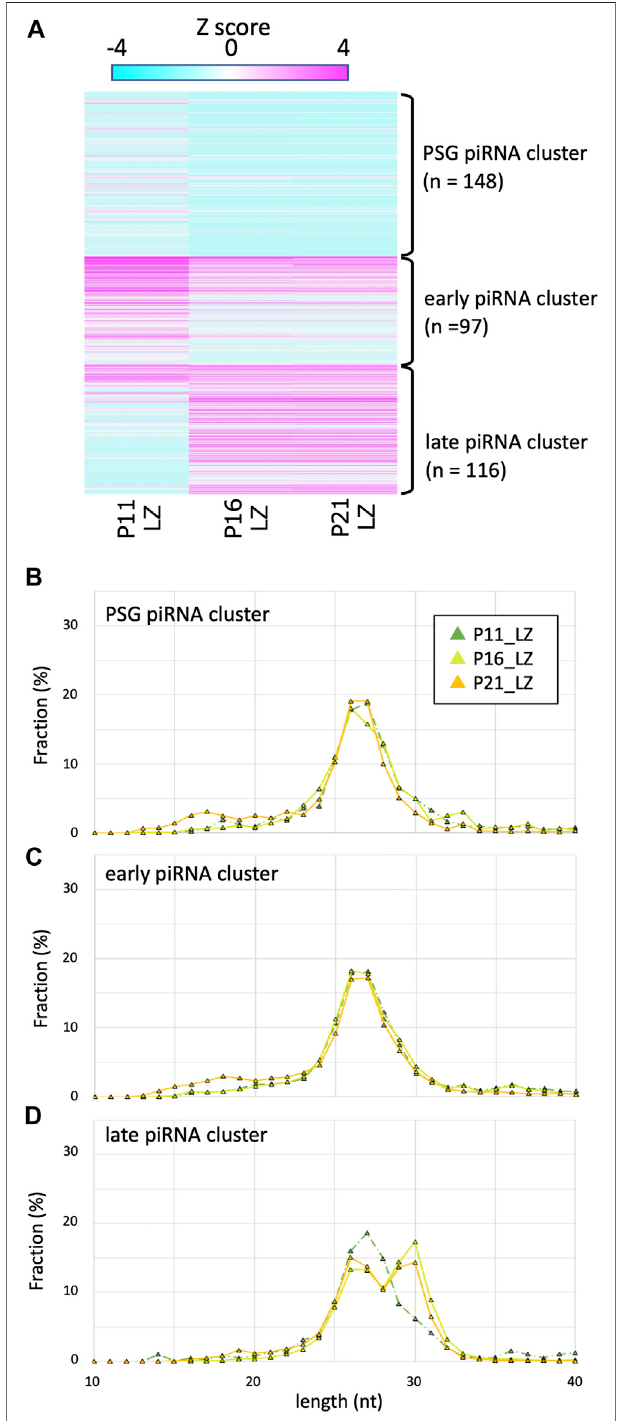
FIGURE 3 | Expression pro fi le and lengths of piRNA clusters in P11, P16, and P21 LZ spermatocytes (A) A heatmap showing the piRNA expression levels for 512 piRNA clusters in different developmental stages. (B – D) Length distributions of piRNAs derived from PSG (B) , early (C) , and late (C) piRNA clusters. The color codes are the same as those in Figure 1B